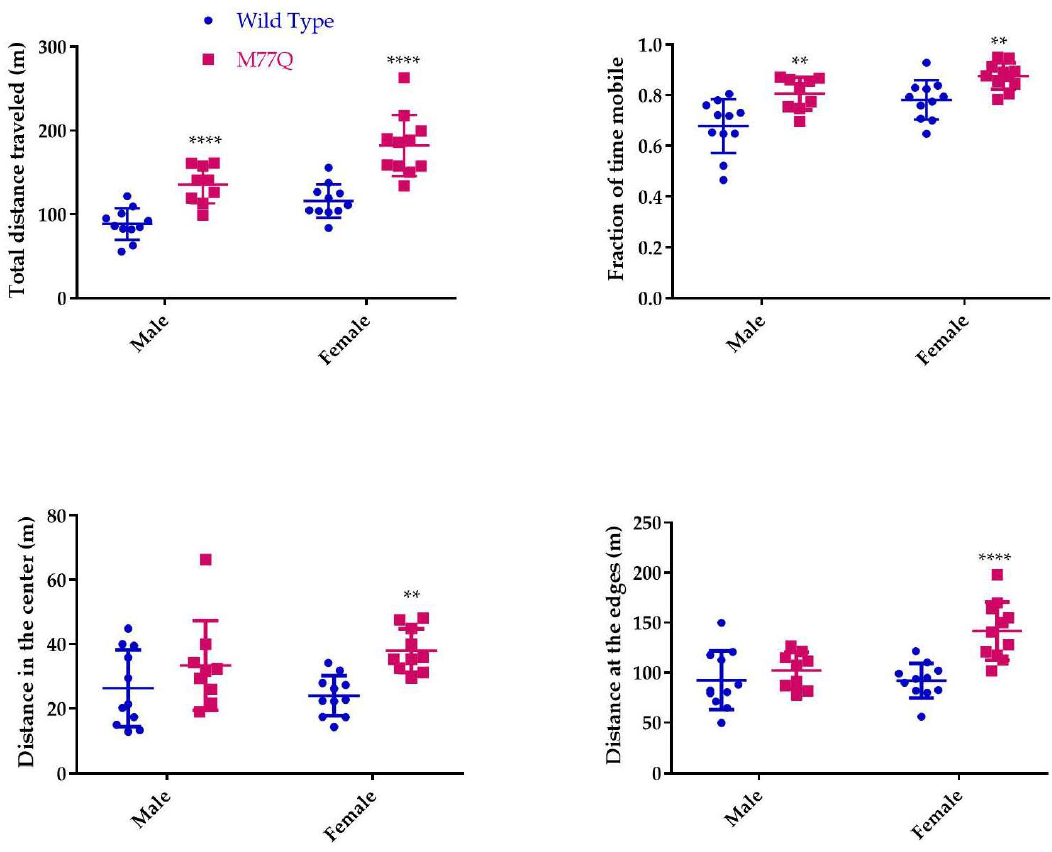
Figure 10. Quantitation of performance on the open field test. We tested 11 wild type and 9 M77Q males and 11 wild type and 10 M77Q females. ** p < 0.01, **** p < 0.0001 by t -test. Antioxidants 2018 , 7 , x FOR PEER REVIEW